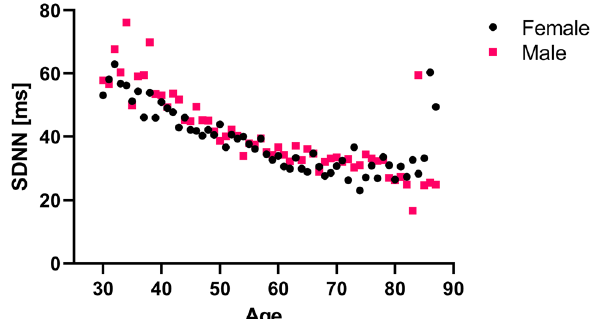
Figure 1. Mean SDNN (ms) as a function of age for men and women from the period before the cold pressure test.